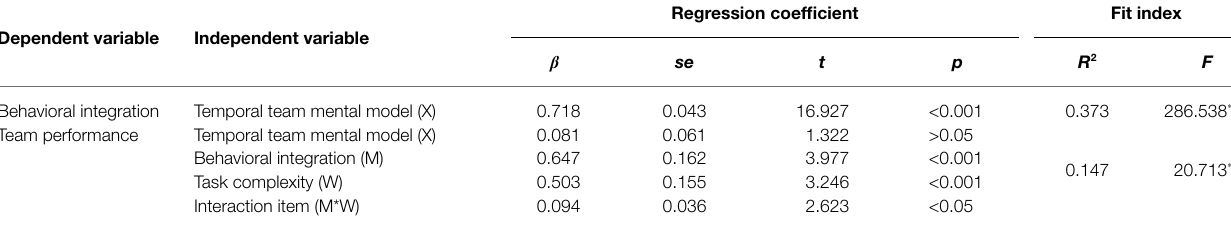
TABLE 5 | Moderated mediating effect model